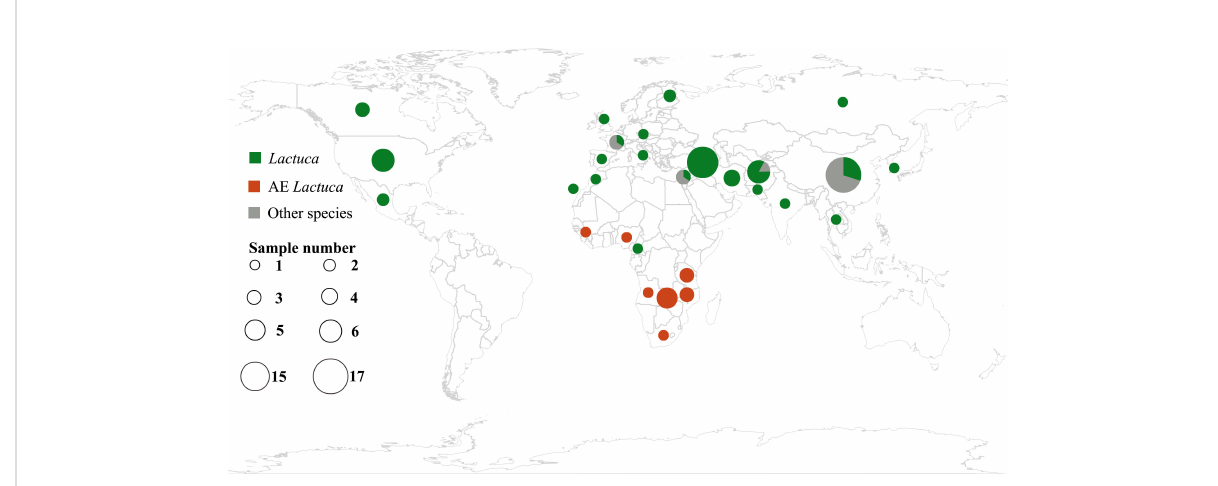
FIGURE 1 Geographic distribution of samples of Lactuca and related species using R package “ rworldmap ” (https://cran.r-project.org/web/packages/ rworldmap/) and “ ggplot2 ”